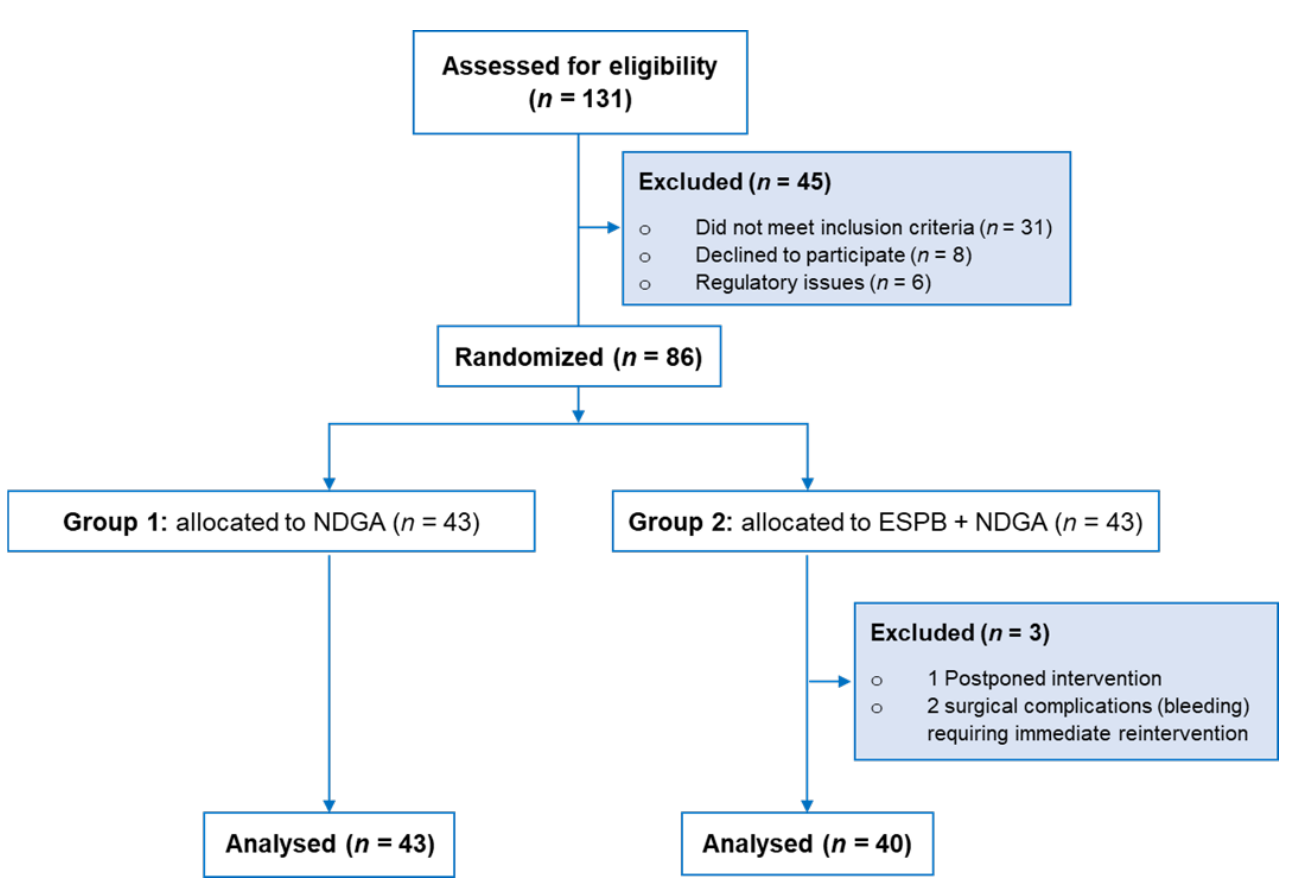
Figure 1. CONSORT diagram showing the patient flow. Abbreviations: CONSORT, Consolidated Standards of Reporting Trials; ESPB, erector spinae plane block; NDGA, Nociception level (NOL) index-directed general anesthesia.